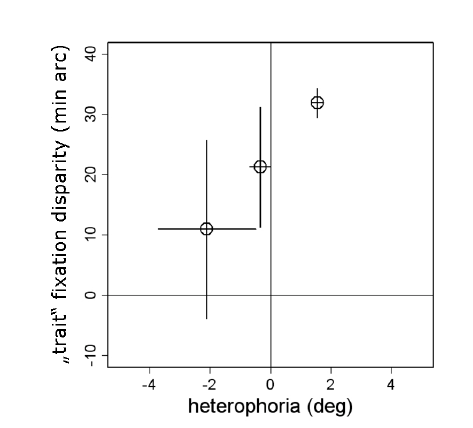
Figure 4: “Trait” fixation disparity (min arc) as a function of heterophoria (deg). The 14 subjects were grouped according to their heterophoria: exophore (< 1 deg), esophore (>1 deg) and orthophore (in between). The graph shows the average heterophoria measure for each group. The circles mark the averages, while the lines represent standard-deviations.